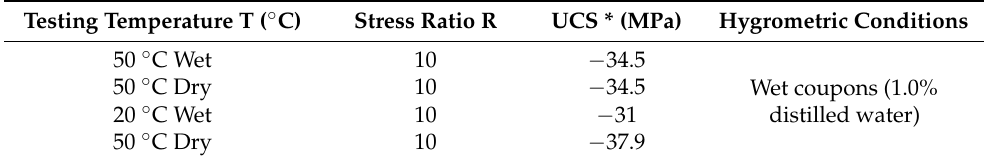
Table 2. Sample parameters of ortho-polyester 63-AX-051.